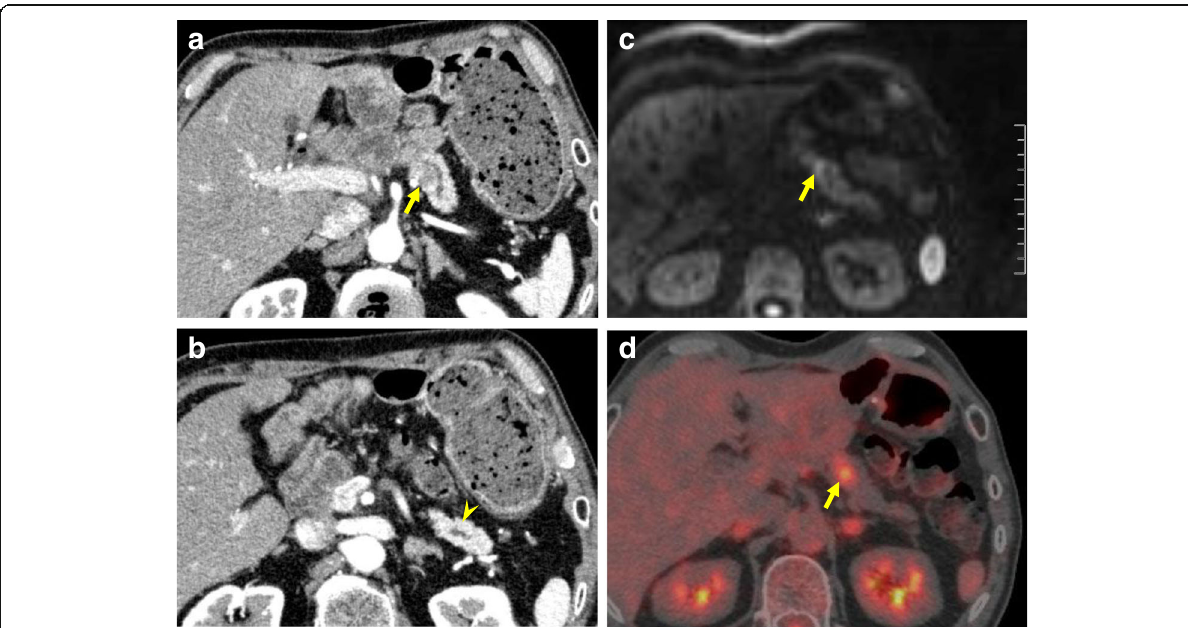
Fig. 3 Preoperative image findings in the second surgery. a CT showed a low concentration region of 2 cm in size near the pancreato-jejunal anastomosis (arrow). b Dilatation of the upstream main pancreatic duct was observed (arrowhead). c MRI showed a tumor with a high signal by DWI at the stenosis of the pancreatic duct. d PET-CT revealed the accumulation of SUVmax 4.0 at the